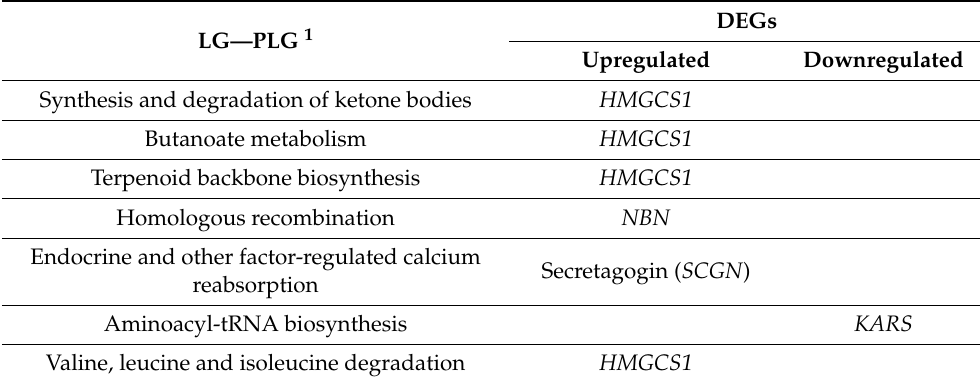
Table 3. DEGs enriched in KEGG pathways in the LG and the